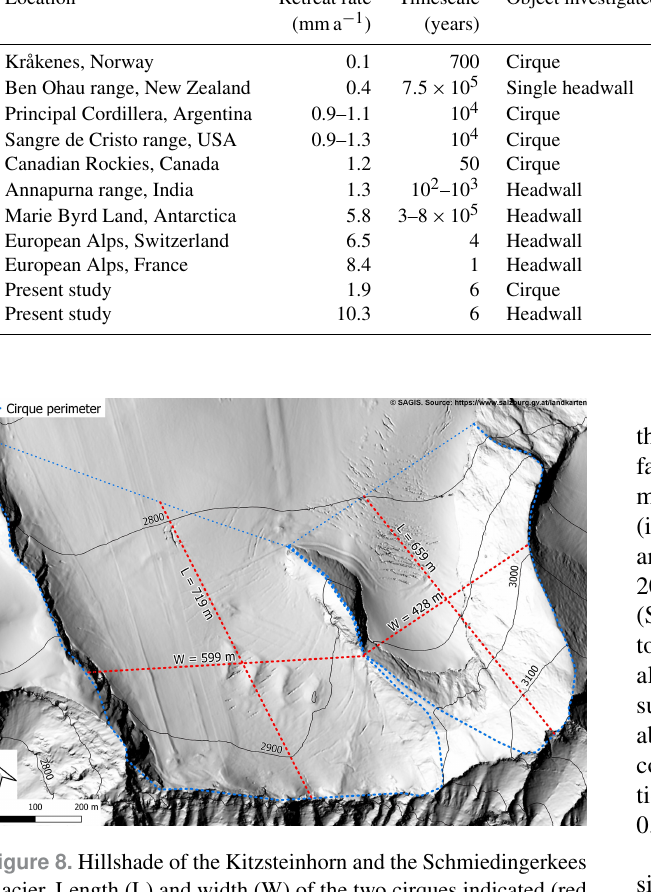
Table 1. Comparison of published cirque wall retreat rates (extended from Sanders et al., 2013; Barr and Spagnolo, 2015). Location